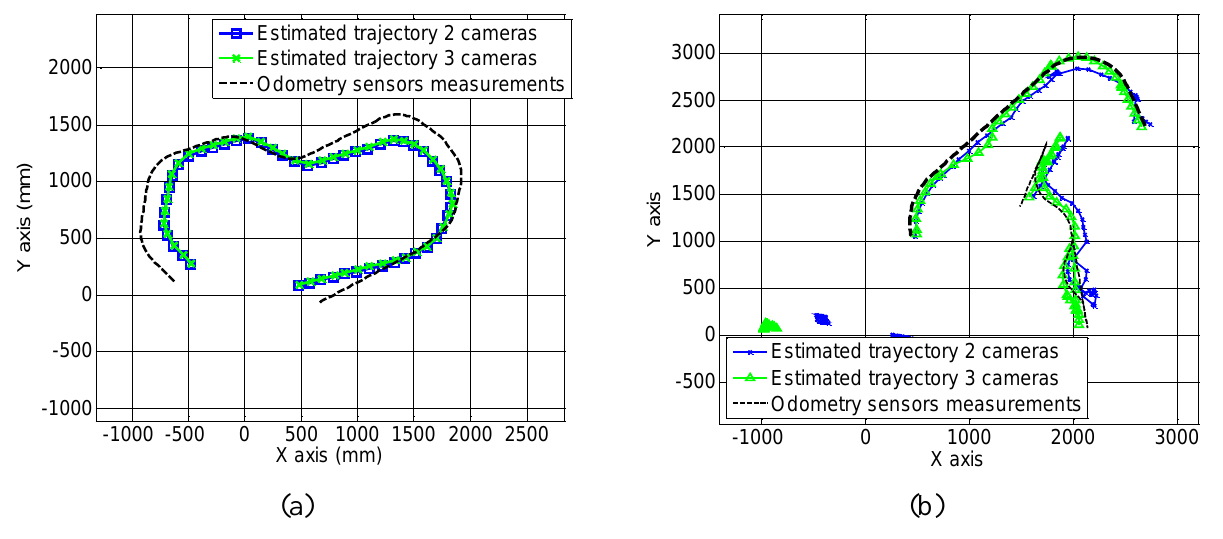
, Y plane (a) Sequence 1 (b) Sequence w w